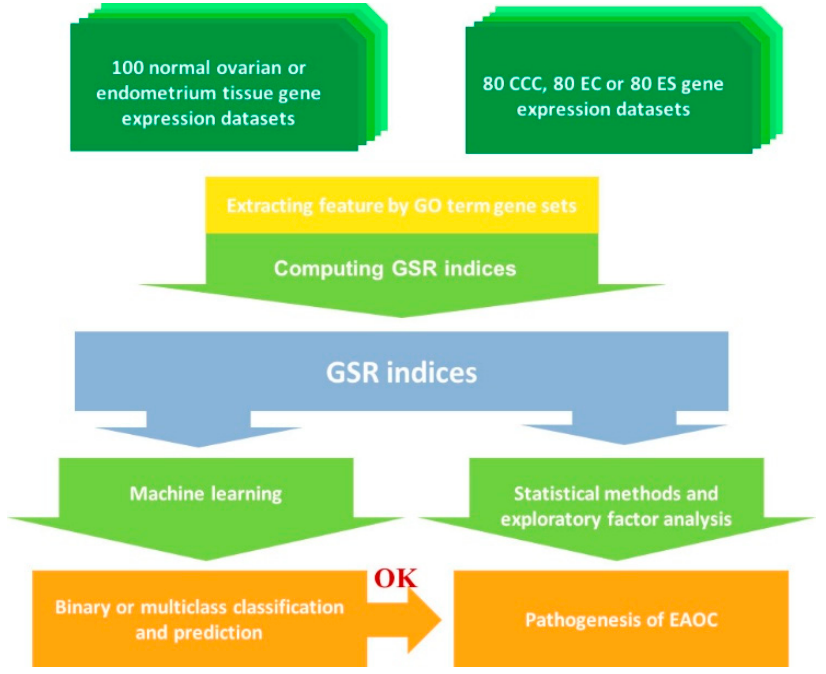
Figure 1. Workflow of the gene set regularity model. The gene set regularity (GSR) index was computed by converting the gene expression ordering of gene elements in a gene set through the Gene Ontology (GO) term or canonical pathway databases. The genome-wide informativeness of the GSR index was assessed by the accuracy of pattern recognition, classification and prediction by machine learning using binary or multiclass classifications. Functionome analyses were carried out to investigate the pathogenesis of endometriosis (ES), clear cell carcinoma (CCC), endometrioid carcinoma (EC) and endometriosis associated ovarian carcinoma (EAOC) by statistical methods, hierarchical clustering and exploratory factor analysis.